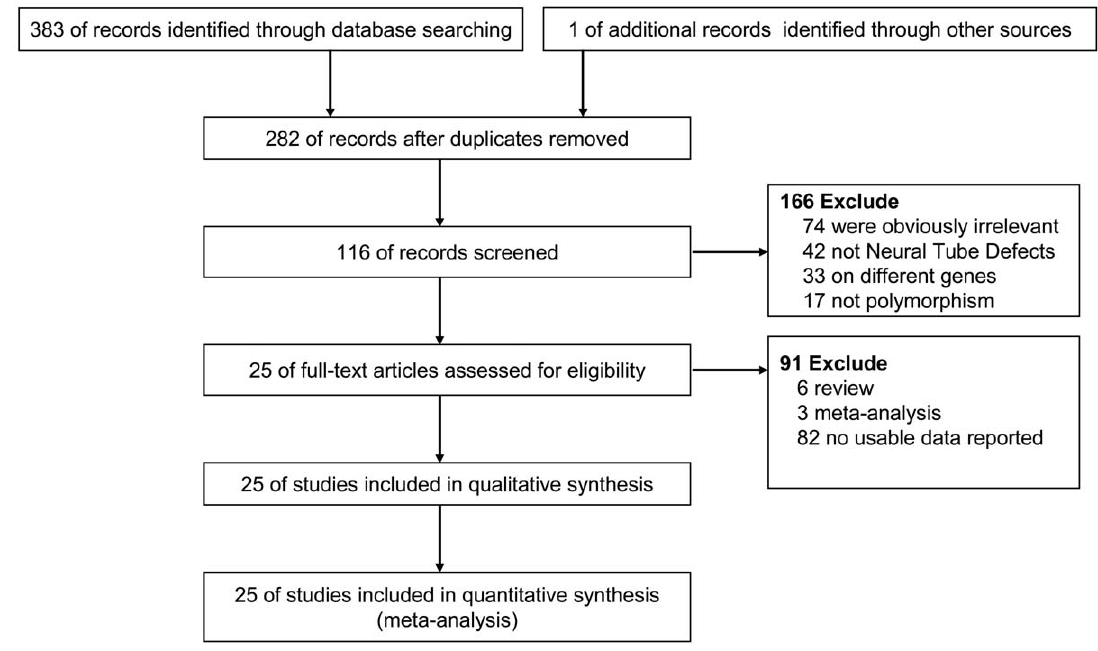
Figure 1. The studies inclusion and exclusion procedures.